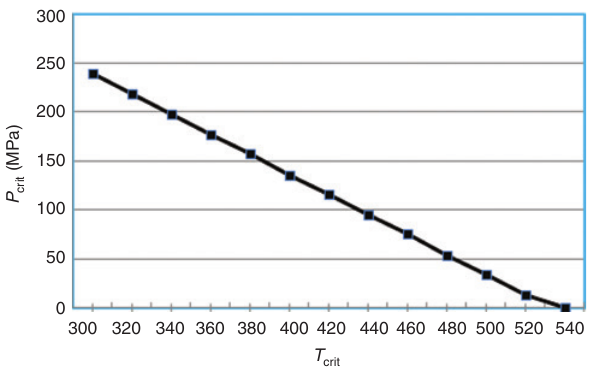
Figure 4: Different combinations of the critical pressure and tem- perature loadings lead to onset of yielding at outer radius of the FG cylinder.